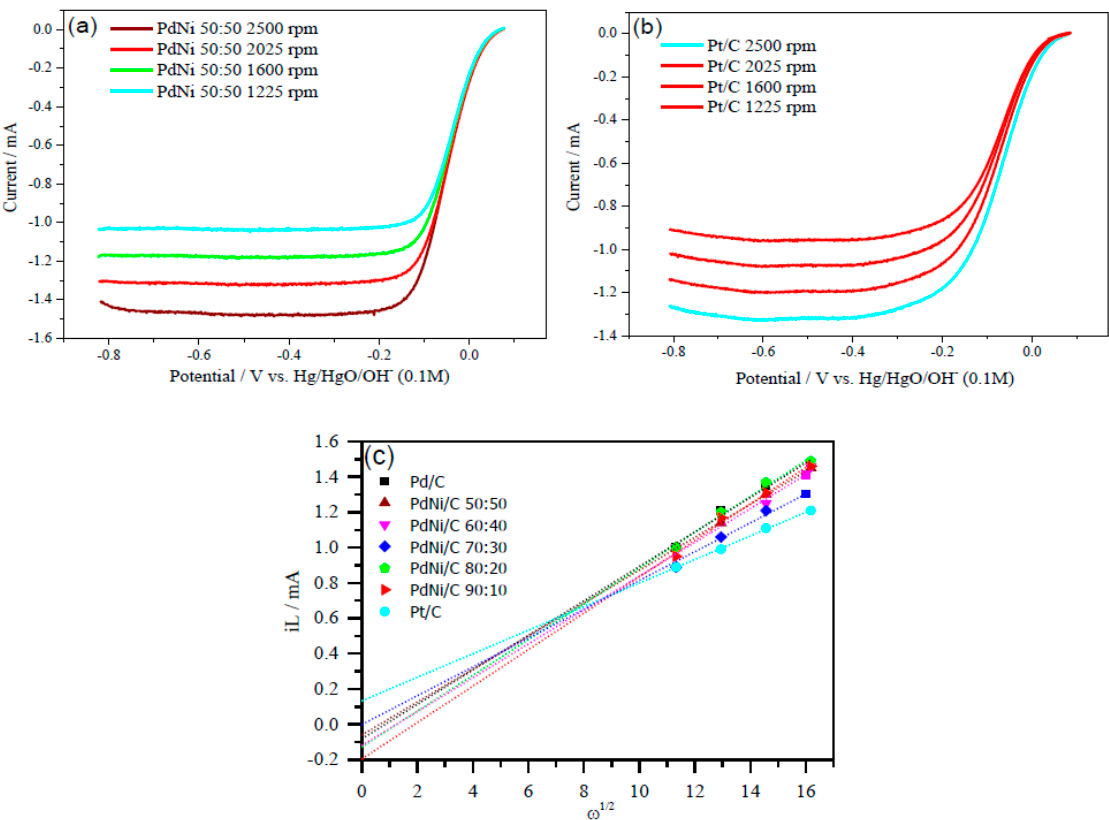
Figure 8. ORR polarization curves of ( a ) PdNi/C 50:50 and ( b ) Pt/C, at various rotation rates (2500, 2025, 1600 and 1225 rpm). ( c ) Levich plots derived from the ORR curves of the PdNi/C at different compositions.